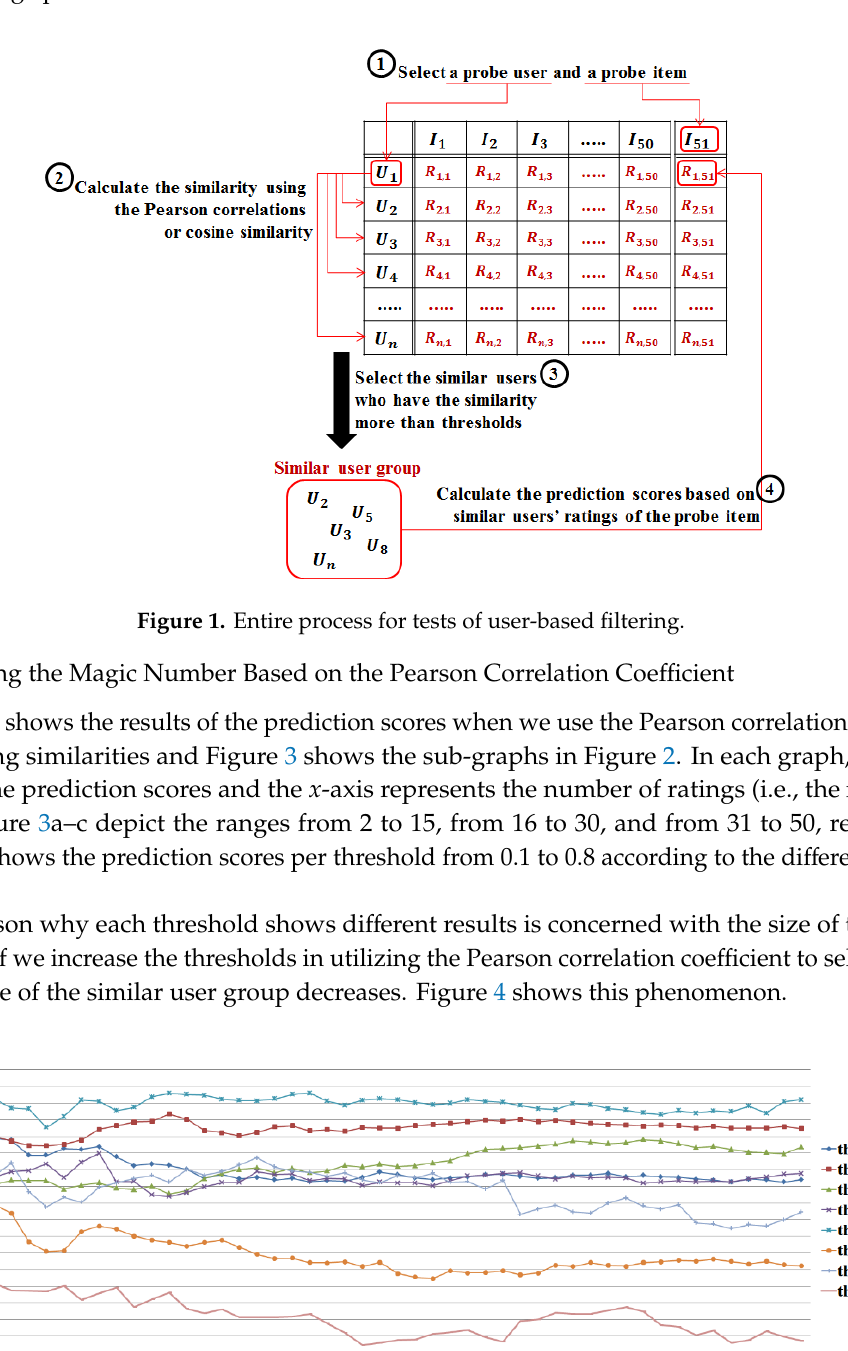
Figure 1. Entire process for tests of user-based filtering.